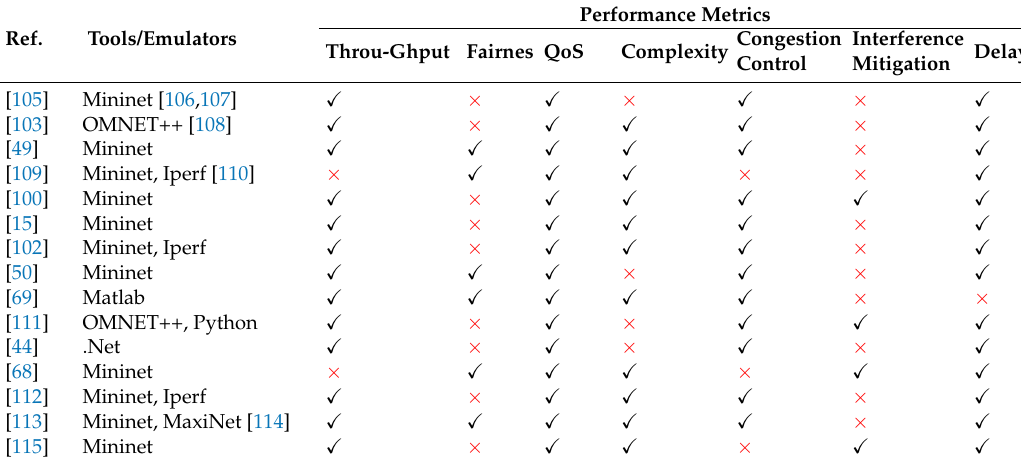
Table 3. Qualitative comparison between different intelligent load balancing techniques in the SDN schemes based on the mathematical tools/emulators and the performance metrics adopted.